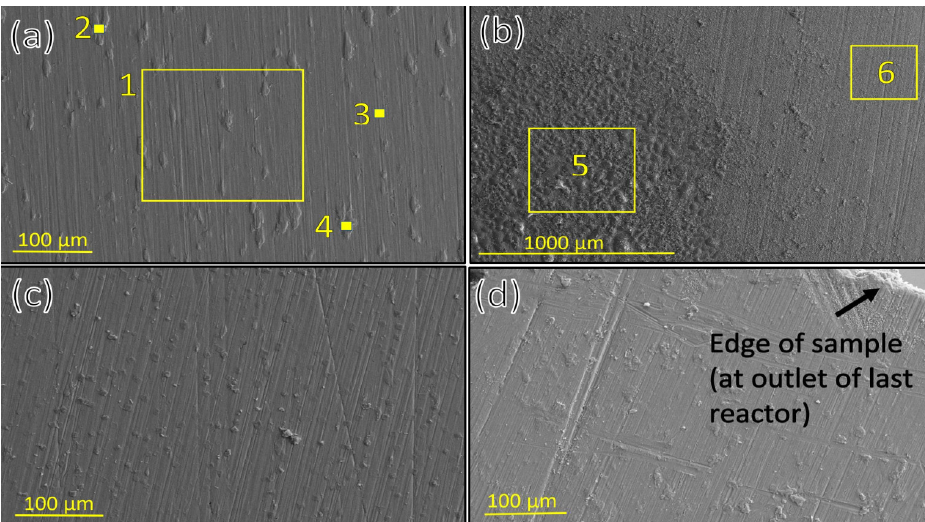
Figure 14. SEM images of the surface of; ( a ) the untested titanium-based alloy, ( b ) the tested titanium alloy sample 1, 1 cm from the inlet end in the first reactor, ( c ) tested titanium alloy sample 1 3 cm from the inlet end of the first reactor and ( d ) tested titanium alloy sample 9 at the end of the last reactor.